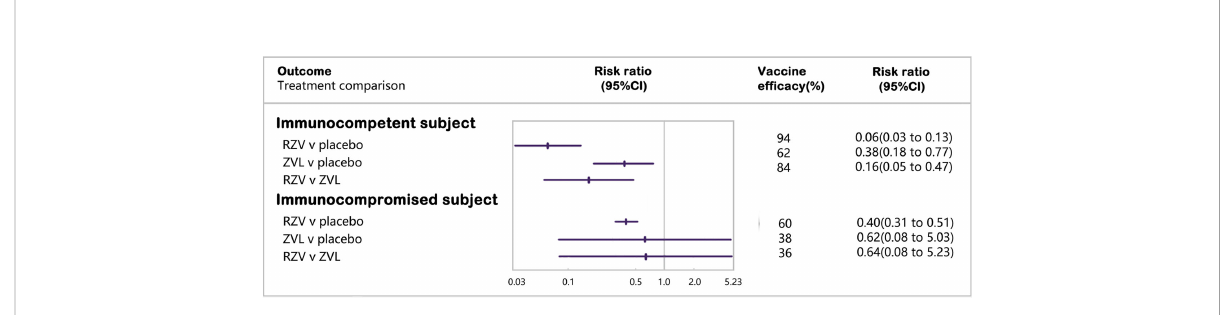
FIGURE 2 Forest plot of vaccine ef fi cacy in reducing cases of herpes